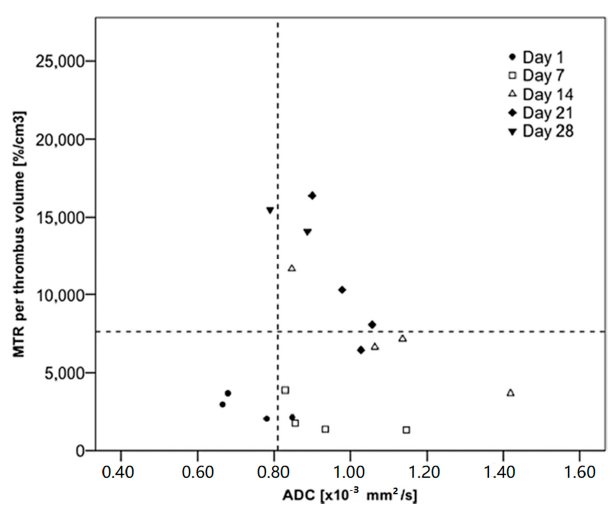
Figure 19. Percentage of magnetization transfer rate (MTR) and apparent diffusion coefficient (ADC) values measured at different time points of venous thrombosis organization. The combination of the percentage of MTR (<7620%/cm 3 ) and ADC (>0.81 × 10 − 3 mm 2 /s) had a sensitivity of 87.5% (95% confidence interval [CI], 47–99) and specificity of 83.3% (95% CI, 51–97) to identify thrombus between 7 and 14 days old, when the fibrin content would be larger. Reproduced with permission from Phinikaridou et al., 2013 [135].